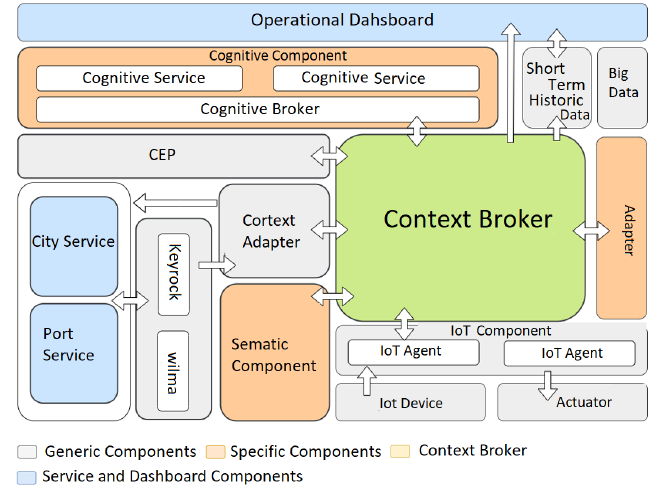
Figure 1. Architectural